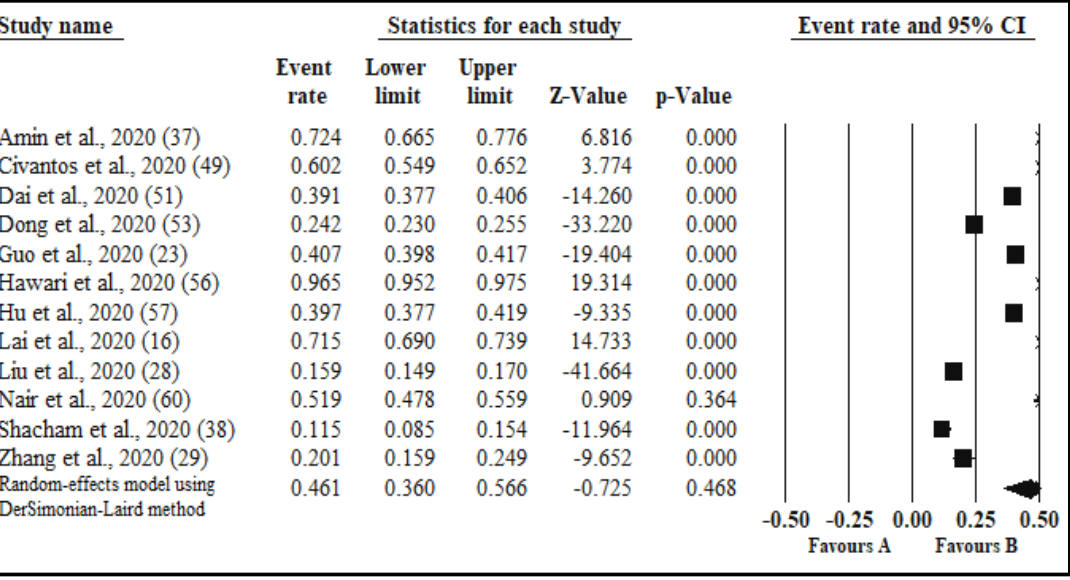
Figure A4. Forest plot for the studies on the prevalence of psychological distress among healthcare workers. The squares and horizontal lines correspond to the study-specific event (anxiety) rates and 95% confidence intervals (CIs). The diamond represents the pooled prevalence and 95% CI of the overall population. The overall pooled psychological distress using a random effects DerSimonian-Laird method was 46.1% (95% CI: 36.0–56.6).